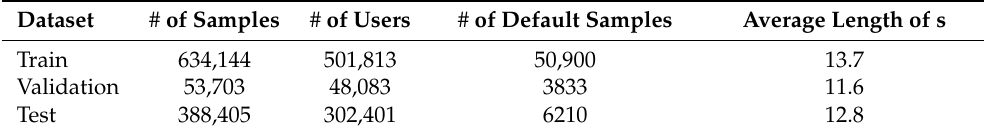
Table 2. Statistical information of the dataset.